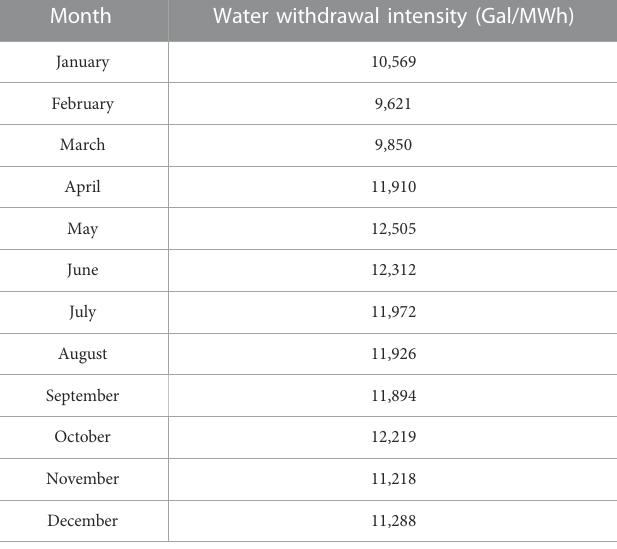
TABLE 2 Monthly water withdrawal intensities for